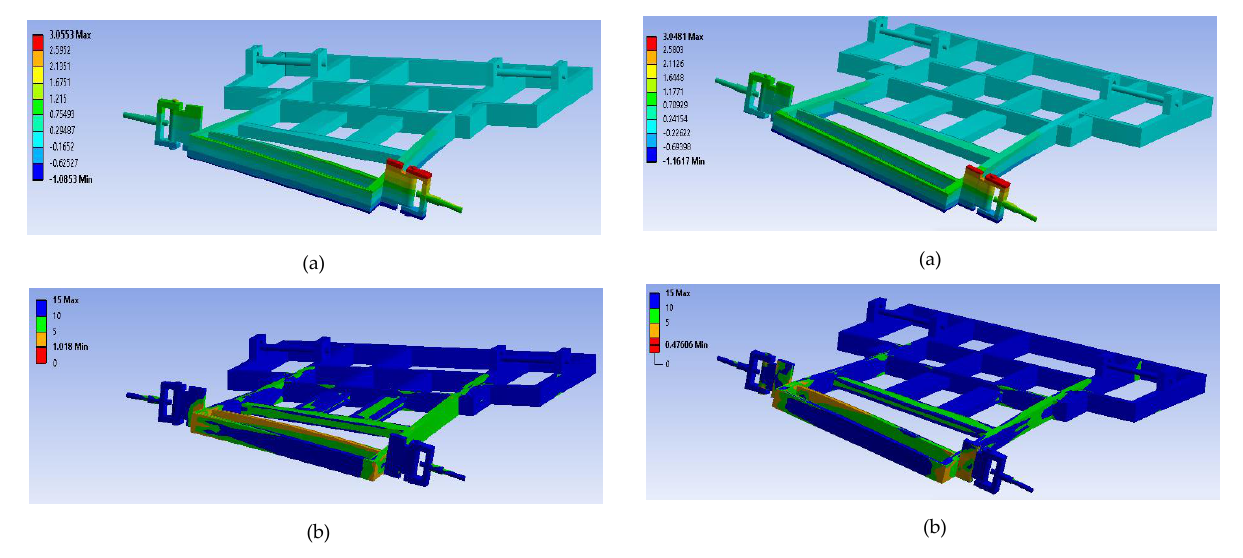
Figure 13: Deformation (a) and safety factor (b) of the second varia- tion chassis simulation